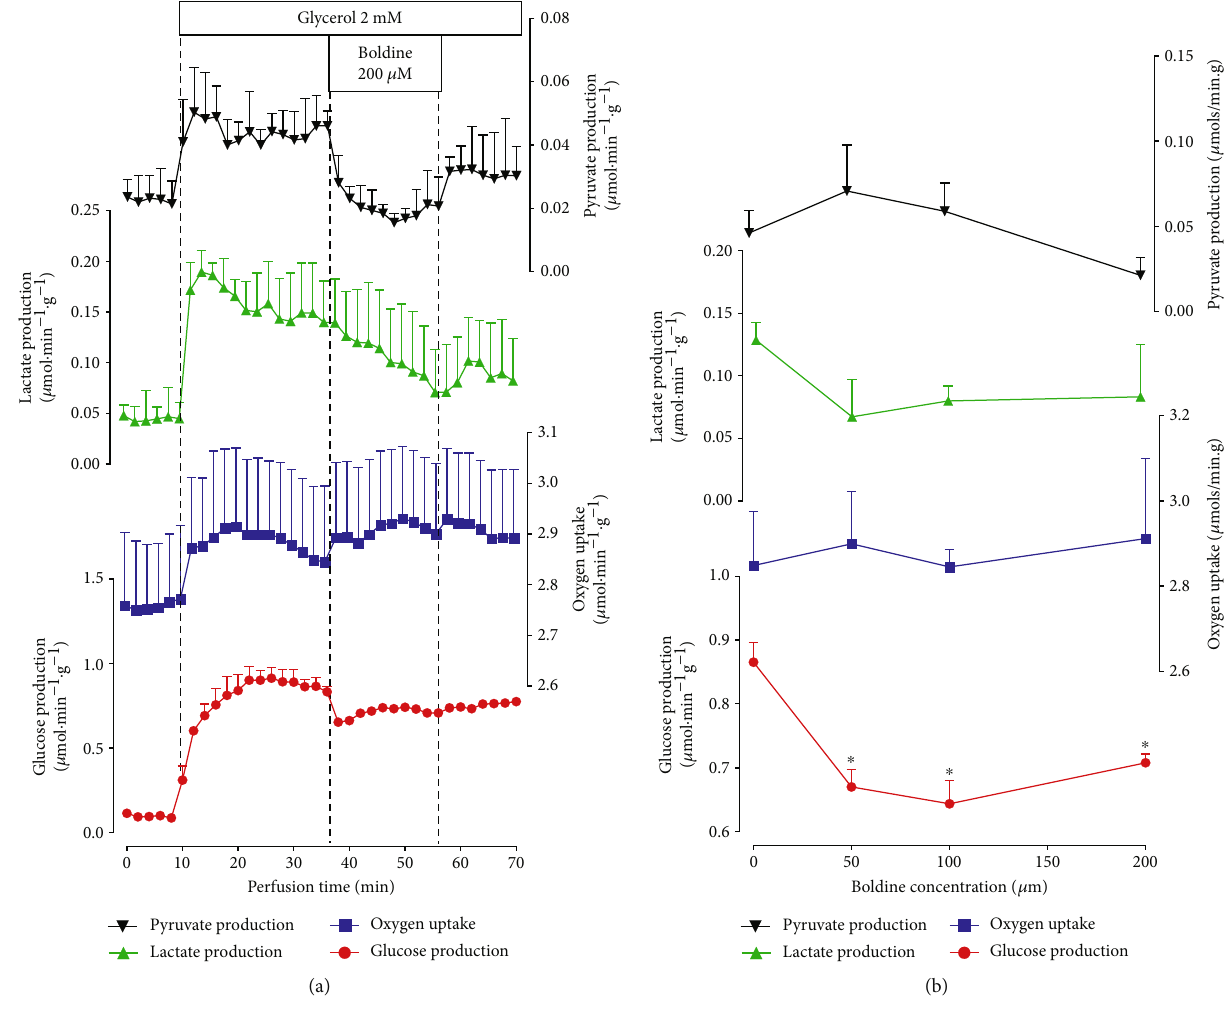
Figure 4: E ff ect of boldine on glycerol gluconeogenesis in the perfused livers isolated from fasted rats. (a) The time courses of the e ff ects of glycerol and 200 μ M boldine and (b) the concentration dependences of the e ff ects of boldine. Livers were perfused as described in the Materials and Methods. In (a), data are the means ± meanstandard errors of 3 to 4 liver perfusion experiments. Boxes near to the time scale indicate the glycerol and boldine infusion periods and concentrations. In (b), the rates of pyruvate, lactate, and glucose productions and oxygen uptake were evaluated at 36 minutes of perfusion time (control condition; n = 12 ) and at 56 min perfusion time ( n = 4 ). Asterisks ( ∗ ) in (b) indicate statistically signi fi cant di ff erences ( p ≤ 0 : 05 ) when compared to the control condition (absence of boldine), as given by the post hoc Student-Newman-Keuls